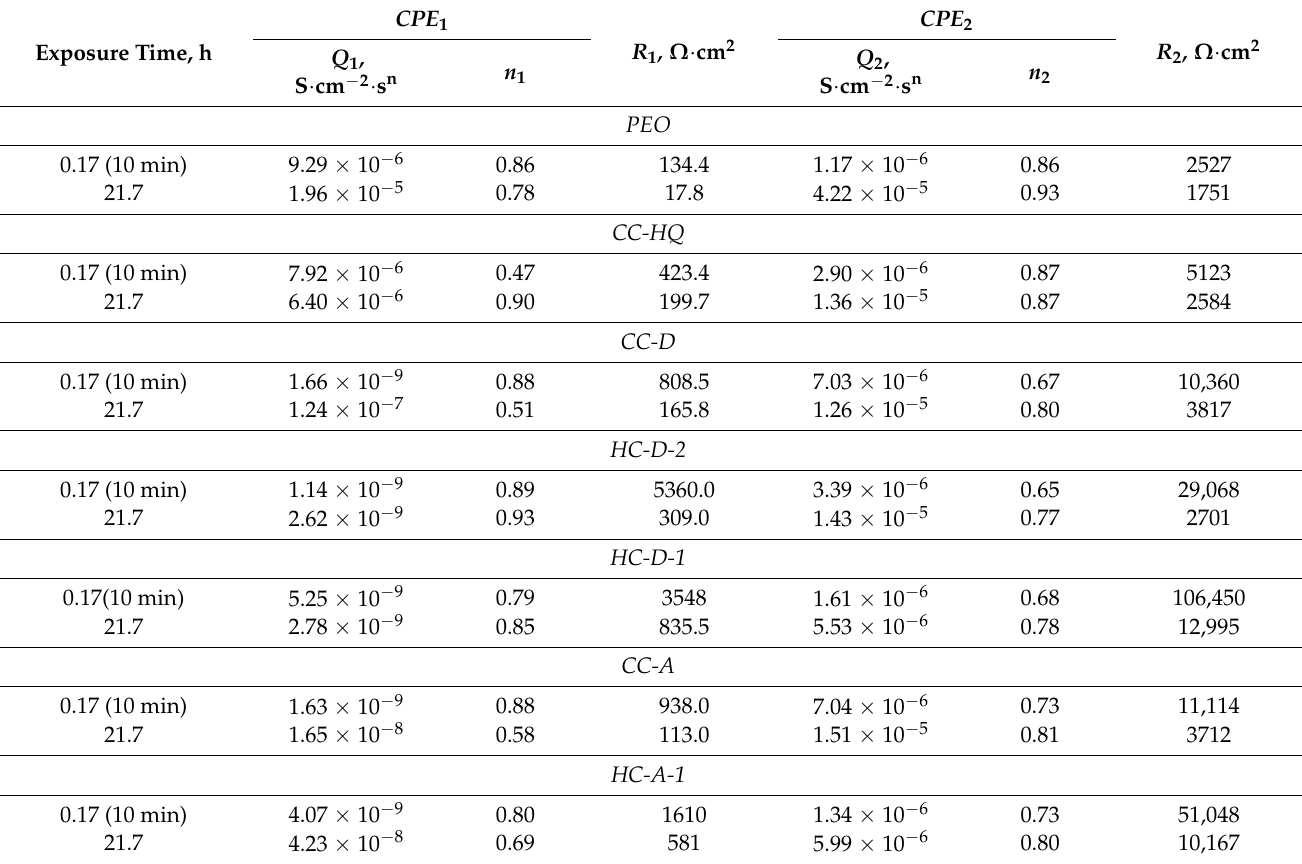
Table 2. Calculated parameters * of the equivalent electrical circuit elements for coated samples after the exposure of the samples to 3.5 wt.% NaCl